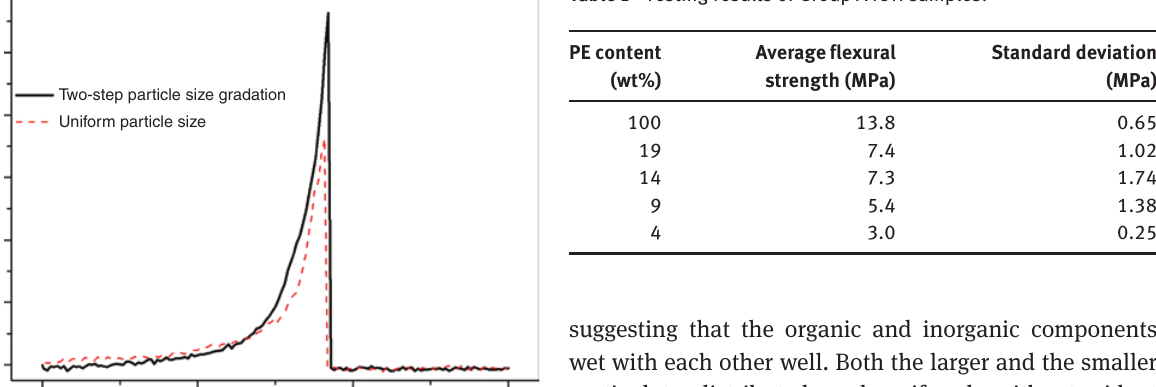
Table 1 Testing results of Group A IOH samples.